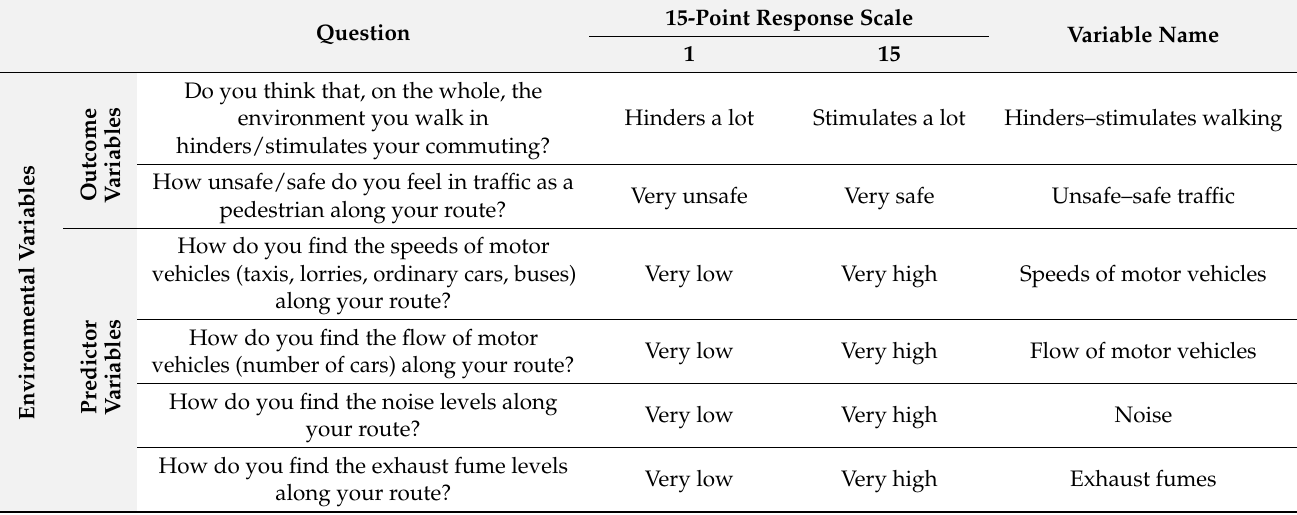
Table 2. The applied items from the ACRES assessing pedestrian’s perceptions of the environment. 15-Point Response Scale